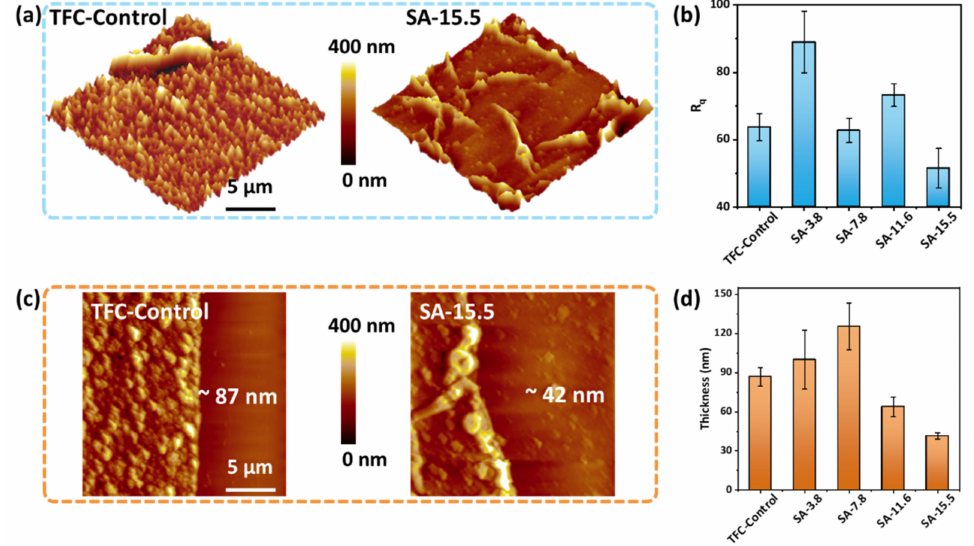
Figure 3. AFM results of polyamide nanofilms isolated from SA–TFC membranes. ( a ) Comparison of surface roughness of TCF-Control and SA-15.5; ( b ) The variations of the roughness of the polyamide nanofilms prepared at different concentration of SA; ( c ) AFM height images of TCF-Control and SA-15.5; ( d ) The changes of thickness of the polyamide nanofilms prepared at different